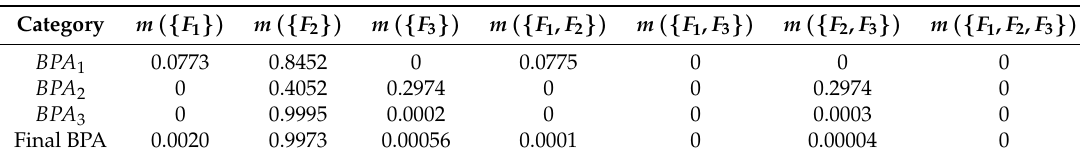
Figure 5. Intersection area of fault models and test model under feature 4 ( Shifting ). ( a ), ( b ), ( c ) shows the Area { F 1 } , Area { F 2 } , Area { F 1 , F 2 } , respectively. Table 6. BPA i ( i = 1, 2, 3) and final